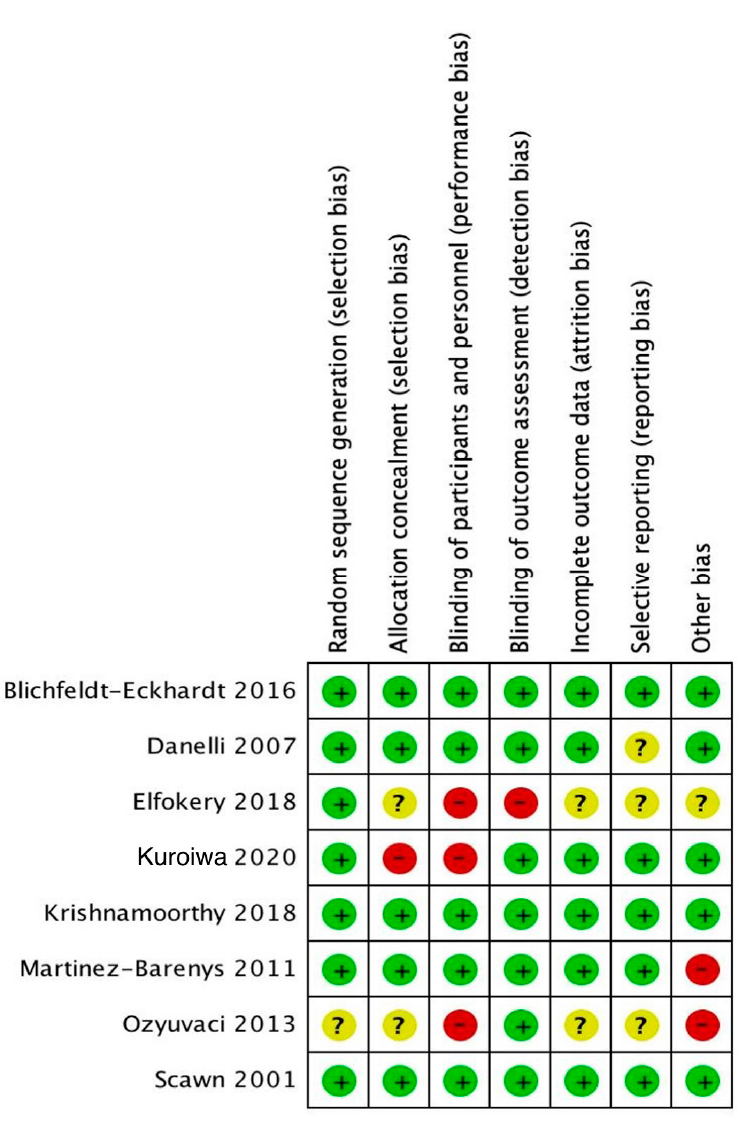
Figure 2. Risk of bias of all included studies. (green for low risk of bias; yellow for unclear risk of bias; –red for high risk of bias) [1,5,6,16,21,22,24,33].